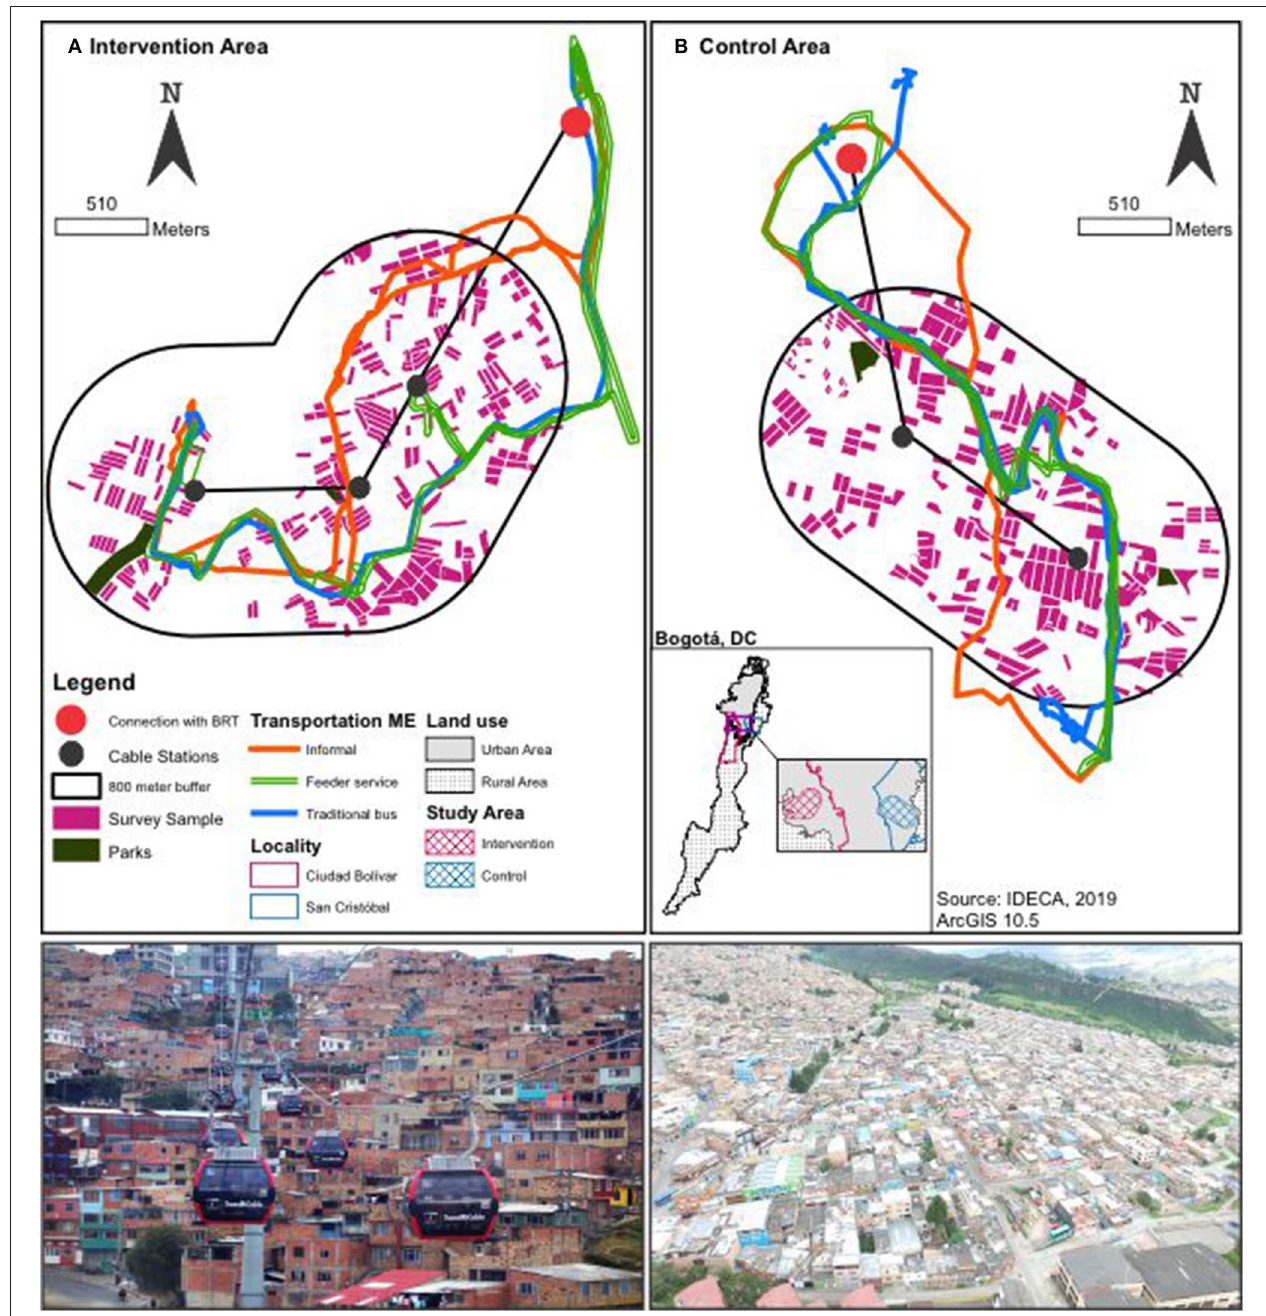
FIGURE 3 | Intervention area in Ciudad Bolívar ( A , left) and control group in San Cristóbal ( B , right).